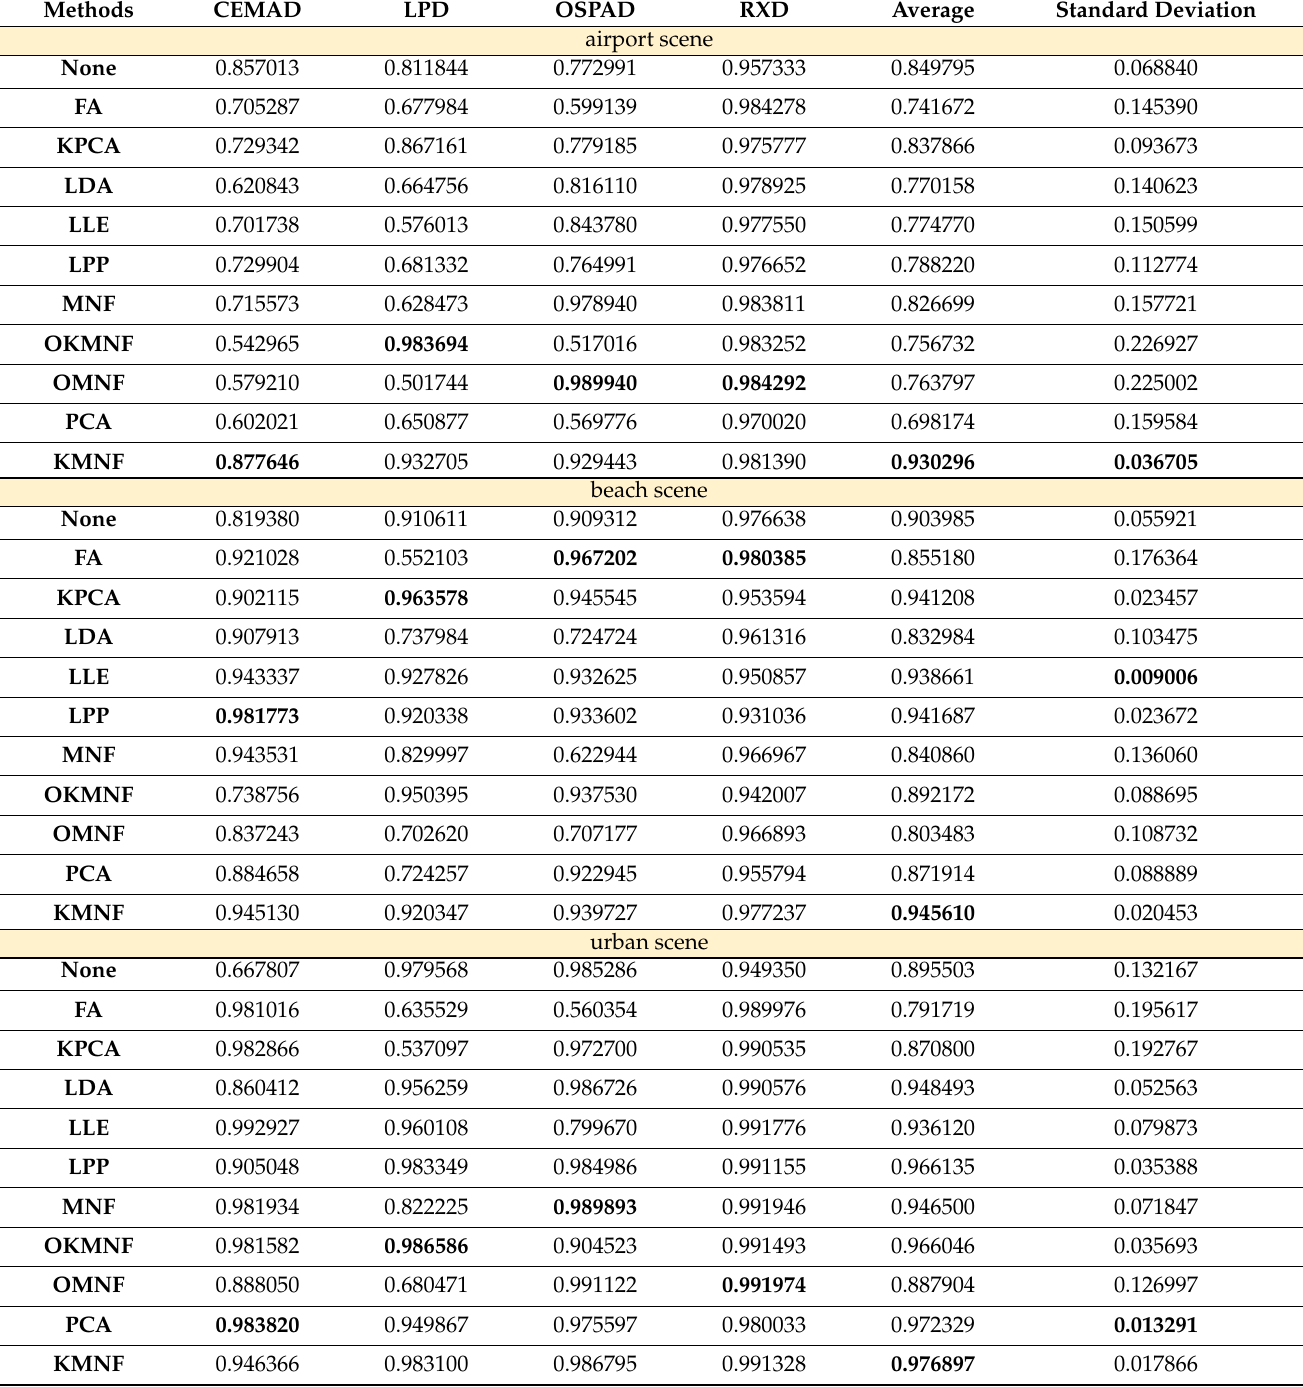
Table 1. The detection capability and adaptability of different feature extraction methods in AD for HSIs over different